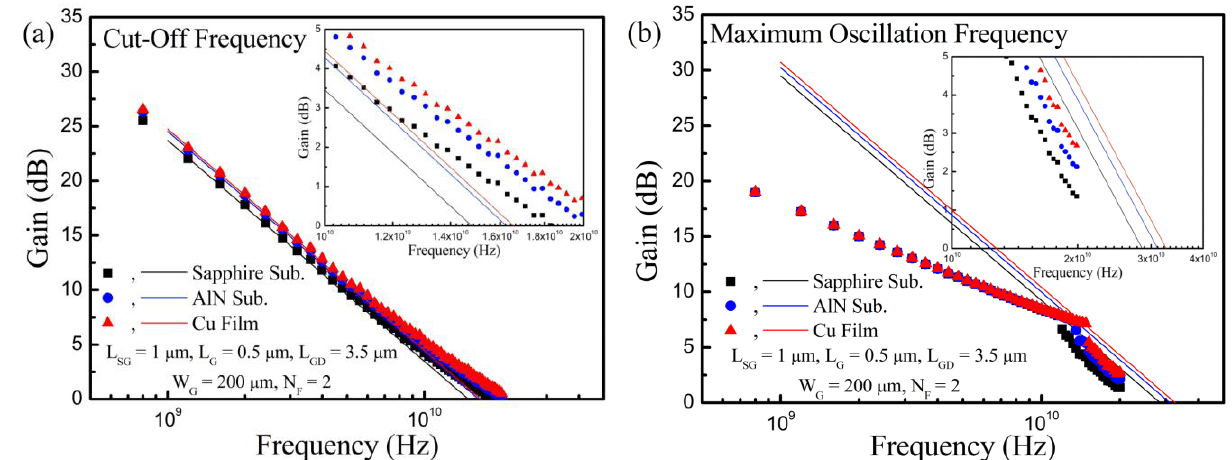
Figure 7. RF characteristics measured in GaN-based HEMTs operated on sapphire substrate, AlN substrate, and Cu film. ( a ) Cut-off frequency and ( b ) maximum oscillation frequency characteristics before and after the back-side processing. Table 1. Summarized GaN-based HEMTs properties corresponding to the substrates/films in this paper.